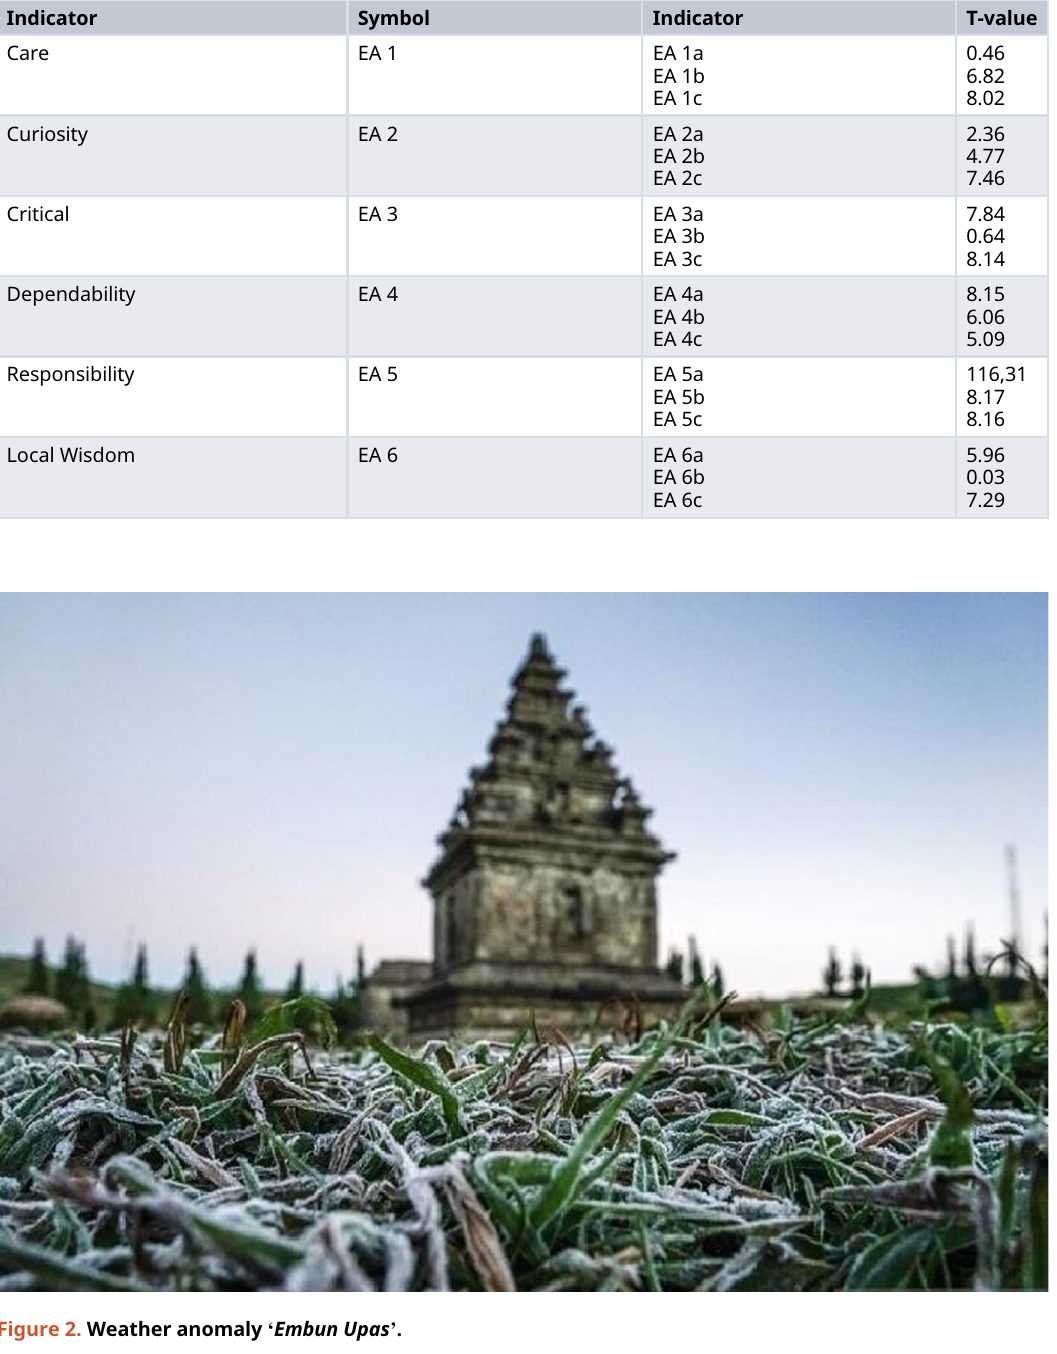
Table 3. T-value second-order confirmatory factor analysis